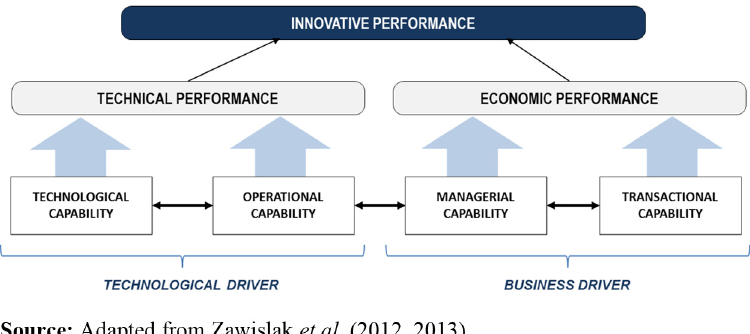
Figure 1. Innovation